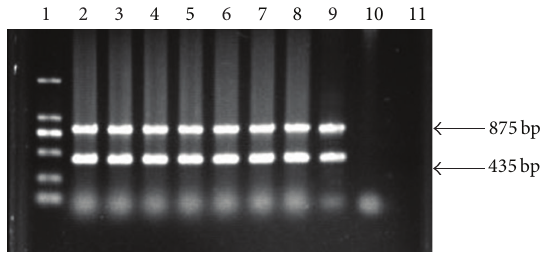
Figure 5: PCR analysis of transgenic goats. Lane 1: 2.0 kb ladder; lanes 2–7: transgenic goats; lanes 8-9: transgenic donor cells; lanes 10: negative control (NT goat); lanes 11: